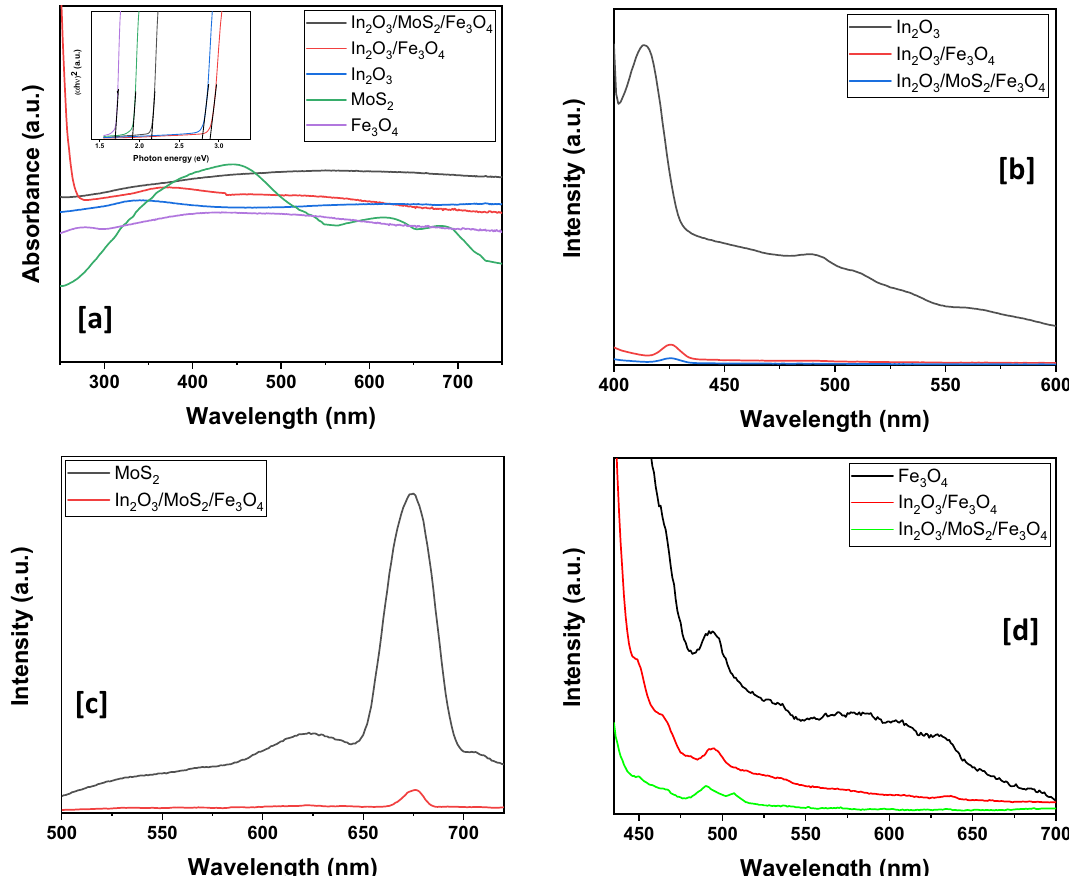
Figure 5. ( a ) UV–visible absorbance spectra of the various nanomaterials with an inset showing their respective Tauc’s plot for calculation of band gaps and ( b , c , d ) Photoluminiscence